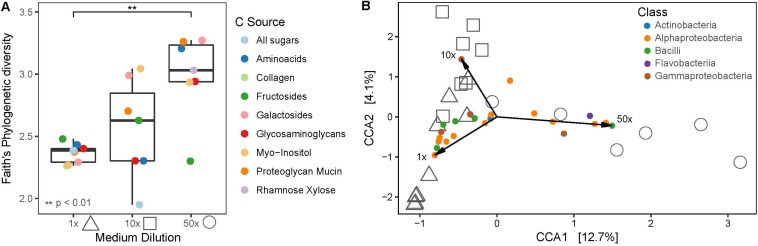
(A) Faith’s phylogenetic diversity of different medium dilutions and carbon sources. (B) Canonical correspondence analysis (CCA) biplot of cultivated bacterial communities on plates and indicative OTUs, colored at Class level. Shapes indicate medium dilutions (triangle: 1x, square: 10x, circle: 50x).